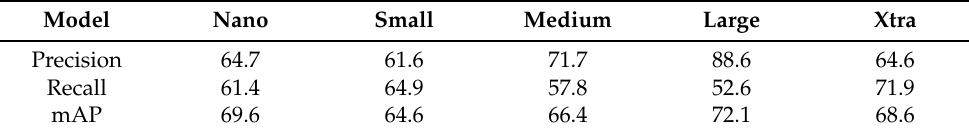
Table 3. Results achieved on validation dataset in